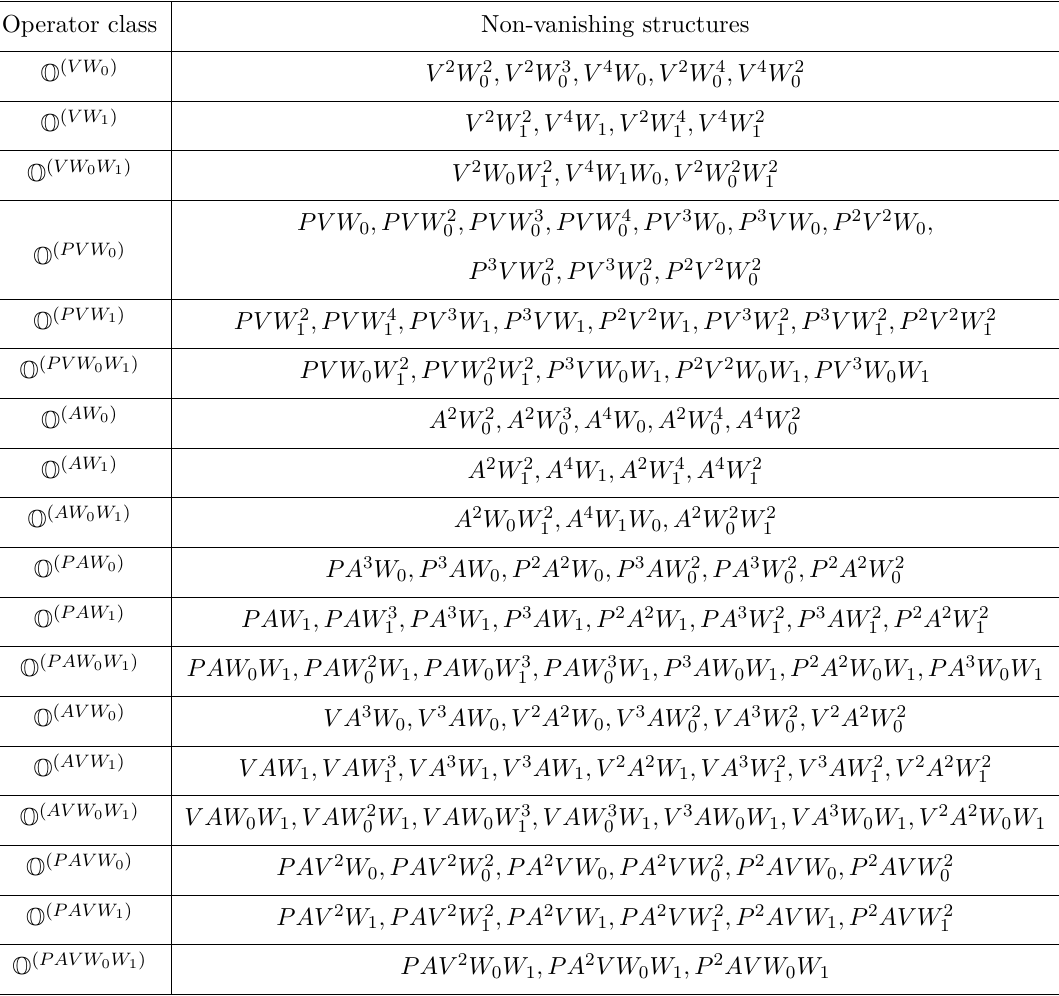
Non-vanishing operator structures in the fermionic UOLEA that involve both (pseudo-)scalar and (axial-)vector